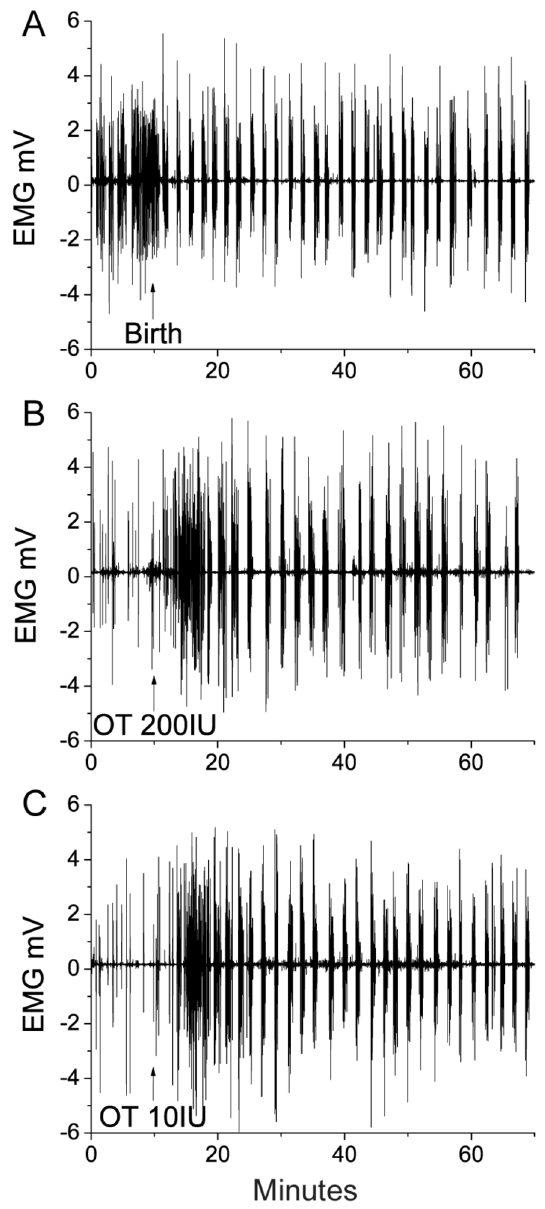
Figure 5. Representative electromyograph uterine activity over time in response to oxytocin